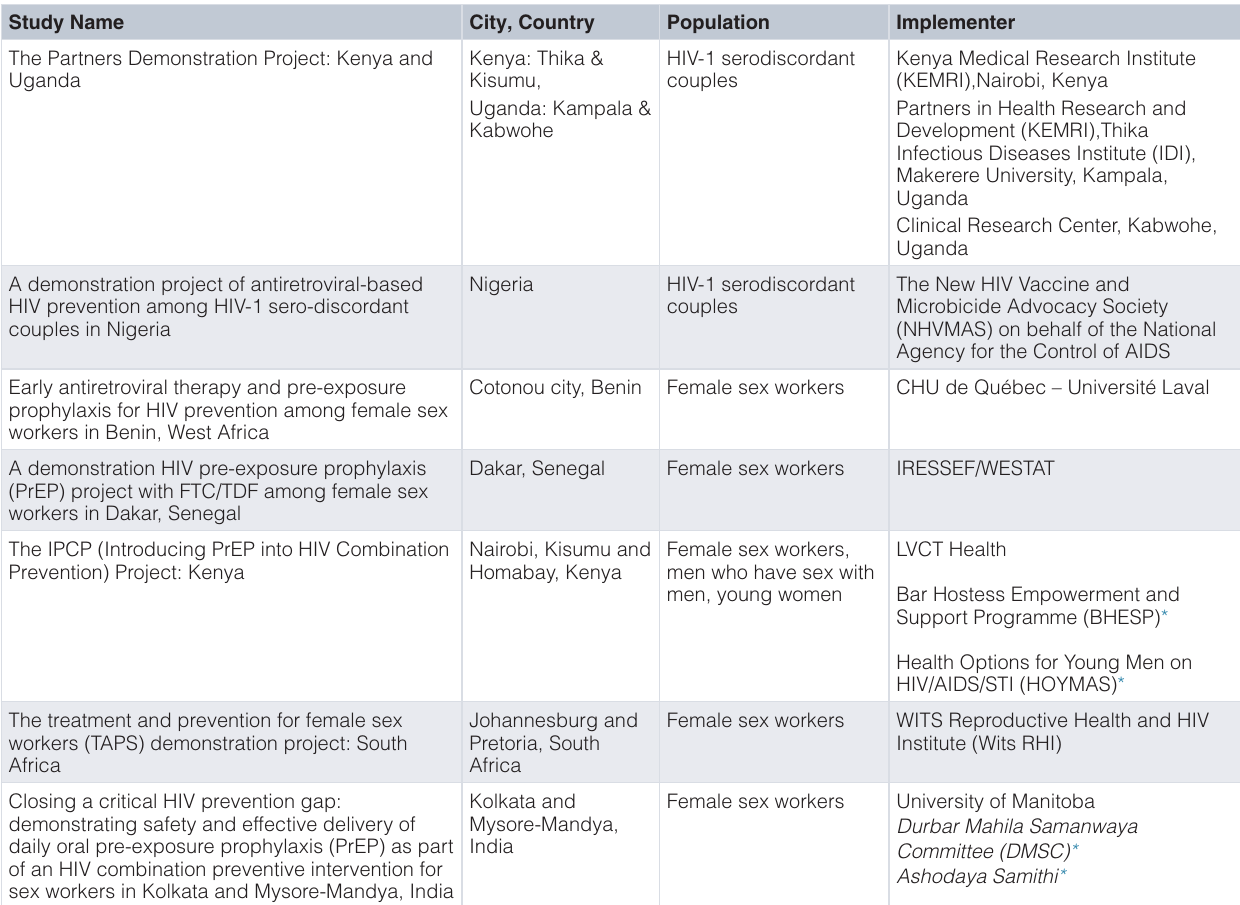
Table 1. List of PrEP Demonstration Projects funded by the Bill and Melinda Gates